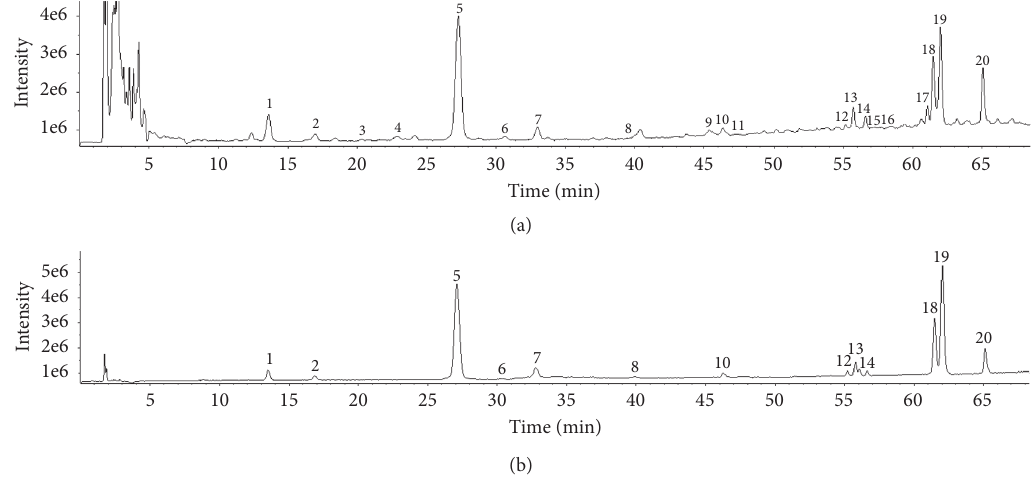
Figure 2: Total ion chromatogram of A. capillaris sample (a) and mixed reference substances (b) (negative ion mode). Table 4: Identification of the common peaks in the A. capillaris fingerprint by UHLC-Q-TOF-MS/MS.